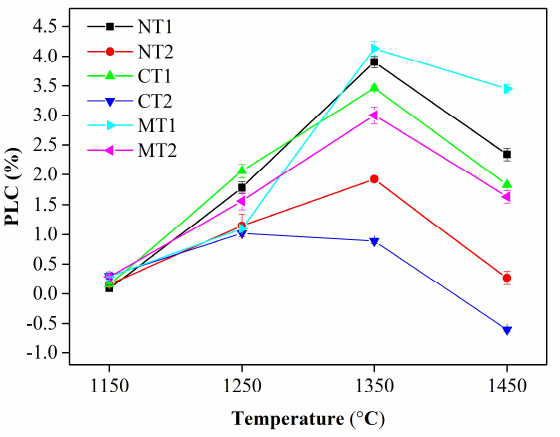
Figure 6. Permanent linear change (PLC) of specimens calcined at different temperatures.